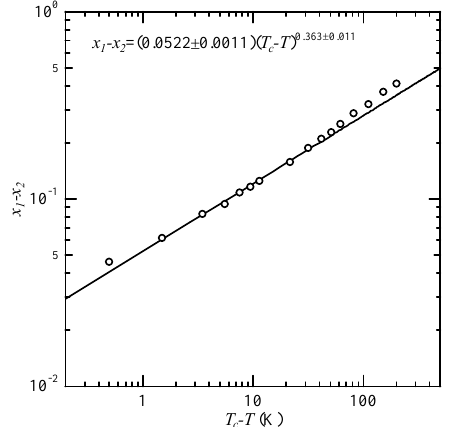
Fig. 5. Log-log plot of the difference x 1 - x 2 in the concentration along the phase boundary.